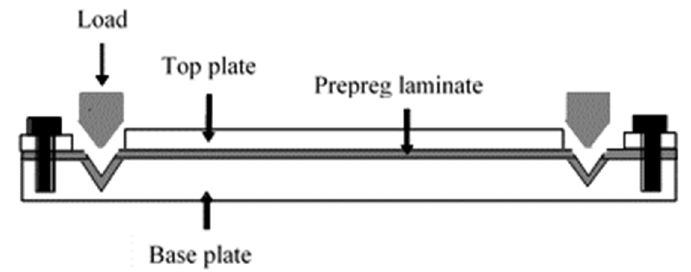
Figure 3. V-slot mechanical fastener [6].